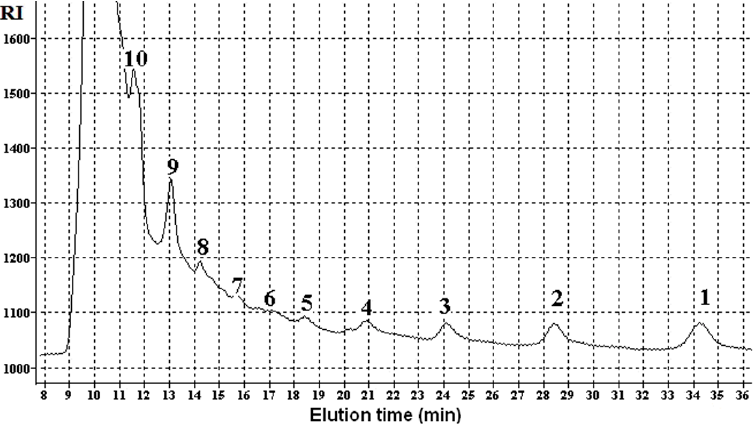
Figure 3. The ligand-exchange chromatogram of the water-soluble cellulose LMWP obtained due to the EBP-processing: 1—glucose; 2–10—LMWP with various polymerization degrees (the numbers correspond to the degree of polymerization); RI—refractive index.